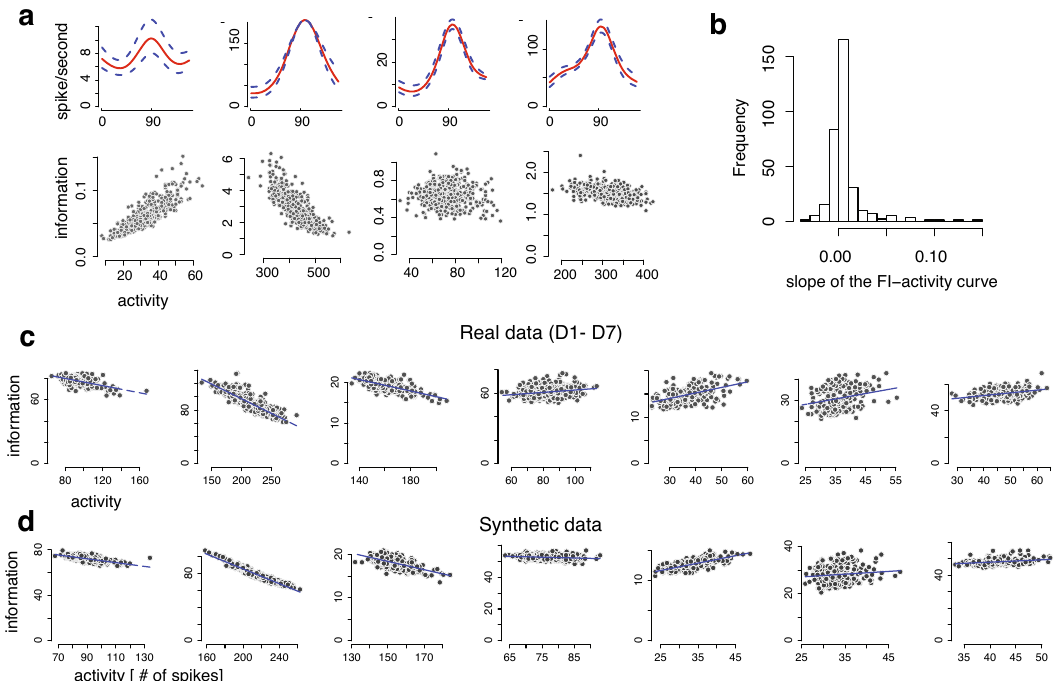
Fig. 6 | Fisher information analysis reveals that higher neural activity barely increases, or even decreases Fisher information. a The relation between the FI and the neural activity (lower panels) and the tuning curves with latent fl uctuation induced by the fi rst fPC (upper panels) in four neuron examples. b Histogram of slopes of the FI-activity for all neurons ( n =402). c Scatter plots showing the rela- tionship between the population FI and the neural activity for each session in real